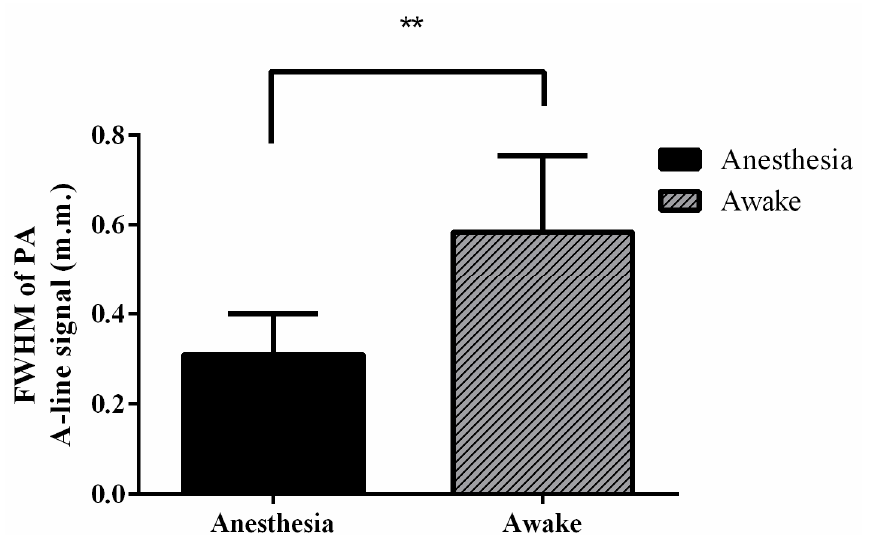
Figure 7. FWHM values of PA A-line signals in anesthetized (black) and awake (gray) rats. The diameter of the SSS blood vessel was significantly larger in the awake state than in the anesthetized state. This may be due to the continuous activity of awake rats, which caused their brains to be more active. Rat brains need more nutrients when the rats are active; that is, more blood needs to be delivered to the blood vessels in the brain, resulting in significant diameter changes. Error bars represent SD. ** p < 0.01 (Paired t -test, n = 4).